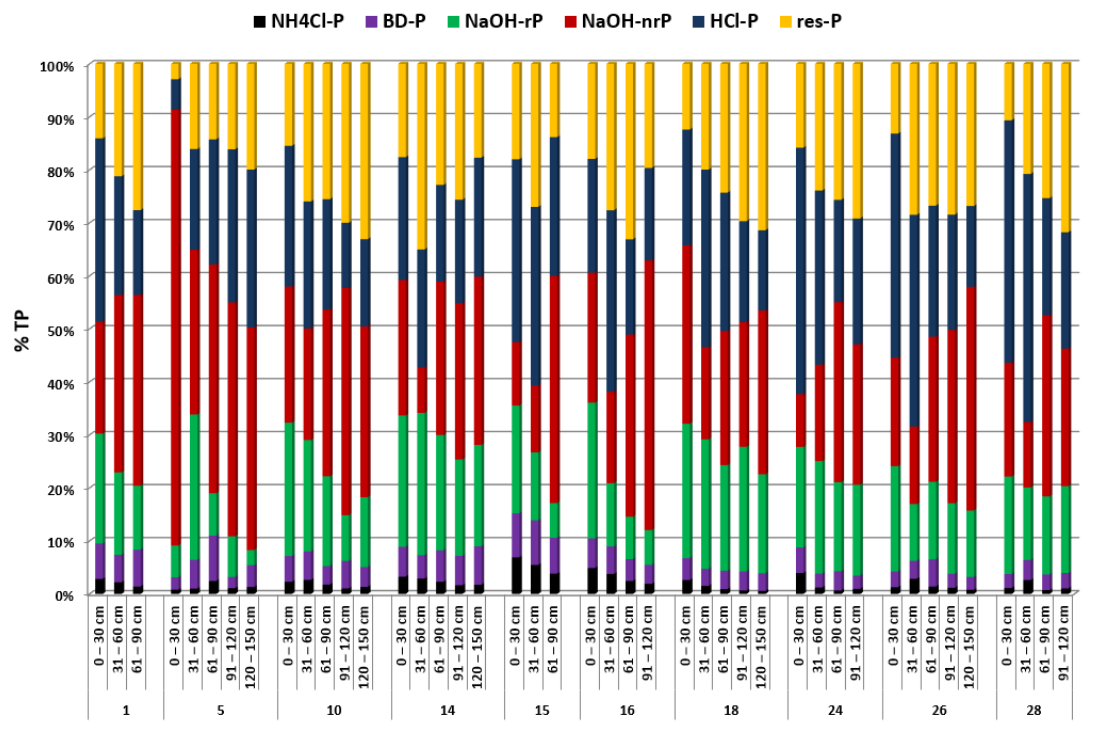
Figure 9. Share of phosphorus fractions (as %TP) at selected bottom sediment research stations.